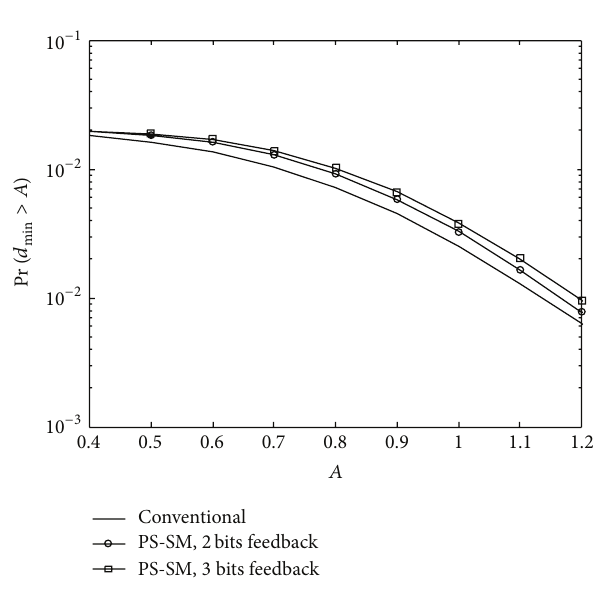
Figure 2: The distribution of minimal Euclidean distance for conventional and proposed